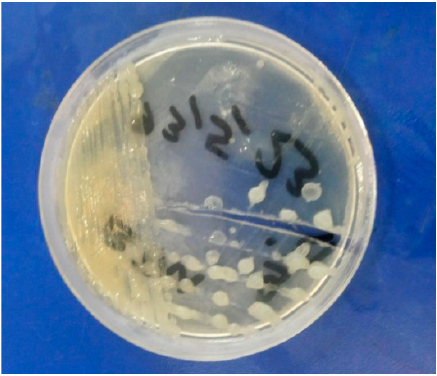
Figure 2. Staphylococcus aureus .